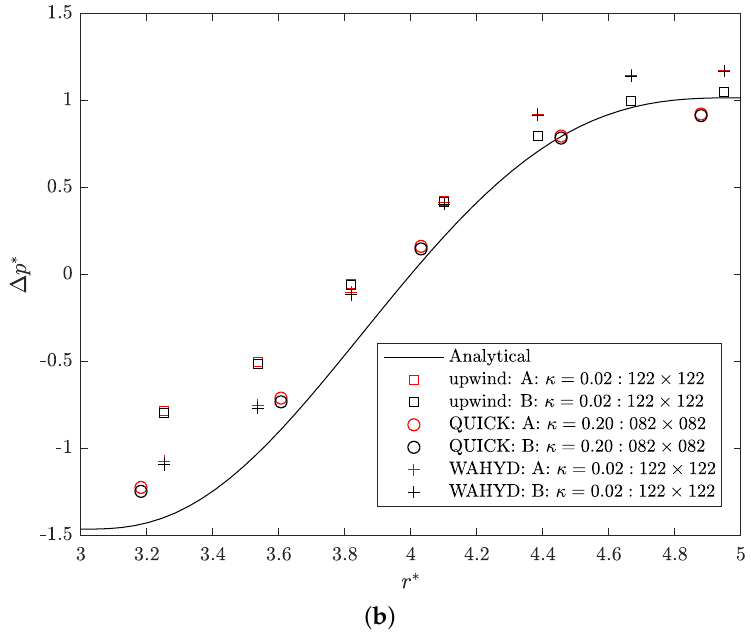
Figure 17. Analytical and best numerical solutions found for the flow between concentric cylindrical walls case, ( θ = 1.5 π ) . ( a ) dimensionless velocity; ( b ) dimensionless pressure.